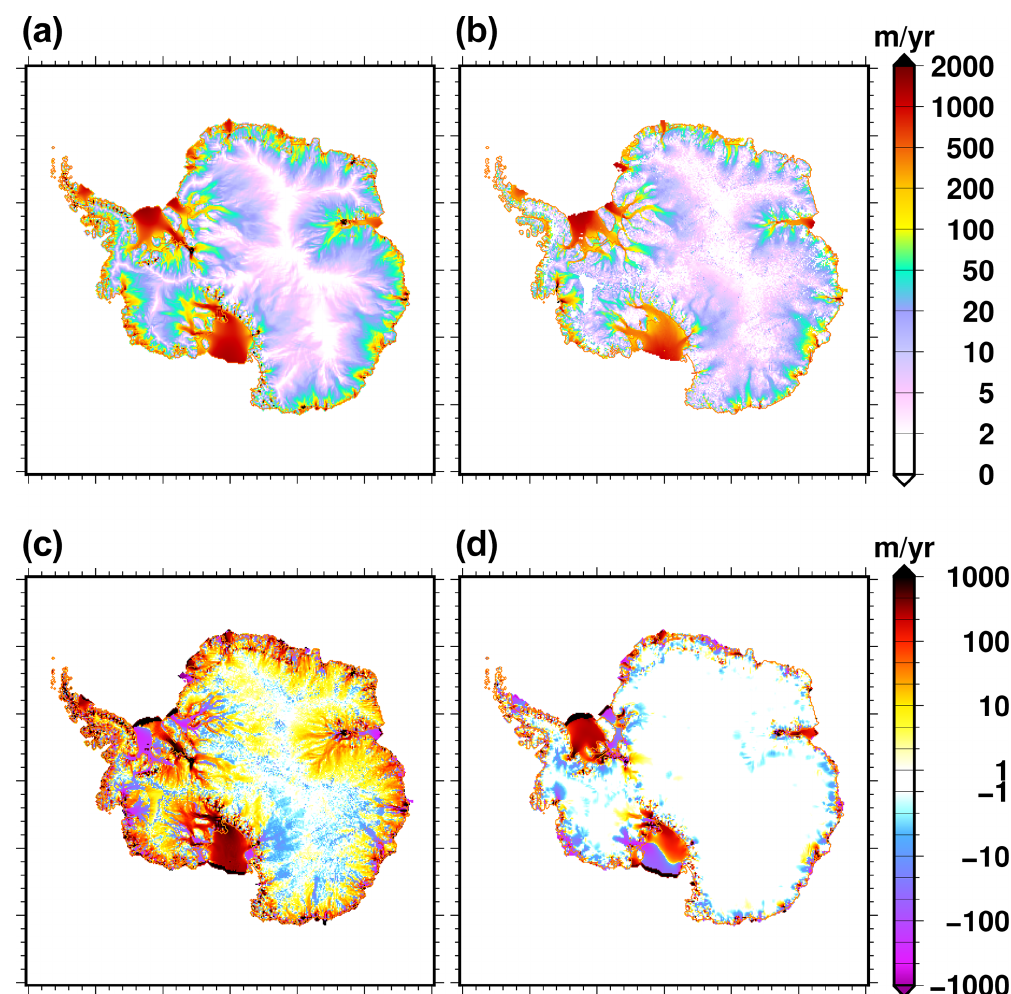
Figure 3. Surface velocity magnitude: (a) simulated at the end (2011–2015) of the historical experiment hist , (b) in the observational datasets of Rignot et al. (2011), (c) difference between (a) and (b) . The surface velocity magnitude change from 2011–2015 to 2096–2100 in the control experiment ctrl_proj is shown in (d) . We use a 5-year mean for the simulated velocity to reduce the impact of interannual variability. The range − 1 to 1myr − 1 is set to white for velocity difference (c, d)